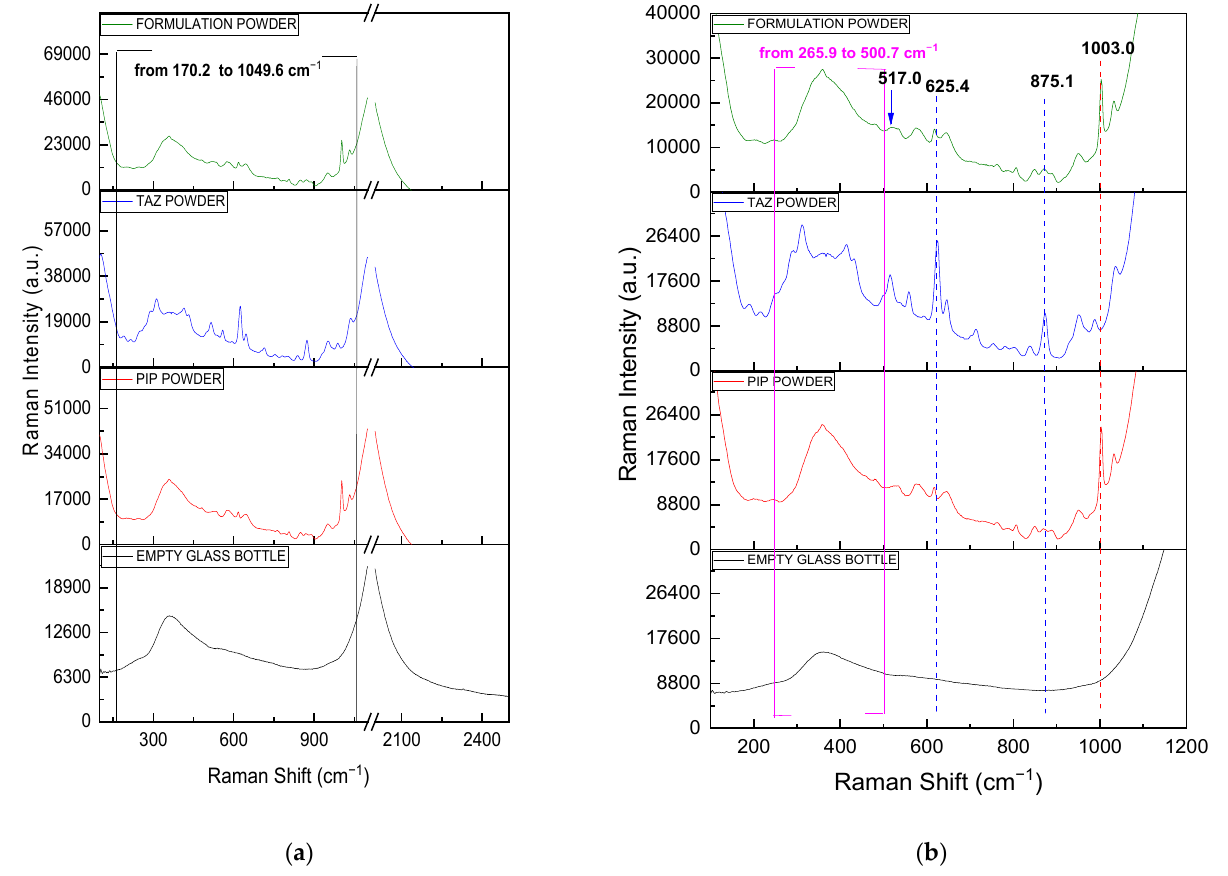
Figure 3. ( a ) Raman powder spectra of PIP, TAZ, and the formulation, obtained through the glass container of the formulation, as well as that of the empty glass bottle (blank sample): ( a ) from 100 to 2500 cm − 1 and ( b ) from 100 to 1200 cm − 1 . The framed spectral region from 170 to 1050 cm − 1 (black frame on the left) corresponds to the wavenumber range where the sample peaks appear. The framed spectral region from 266 to 500 cm − 1 (pink frame on the right) corresponds to the wavenumber range where the sample peaks can hardly be detected, mainly in case of PIP and formulation powder, as they are shadowed by a broad glass peak. Differences between PIP and formulation spectra due to TAZ presence in the commercial mixture are shown with blue dotted lines and the blue arrow at 517 cm − 1 . The characteristic peak of PIP at 1003 cm − 1 is at the red dotted line.